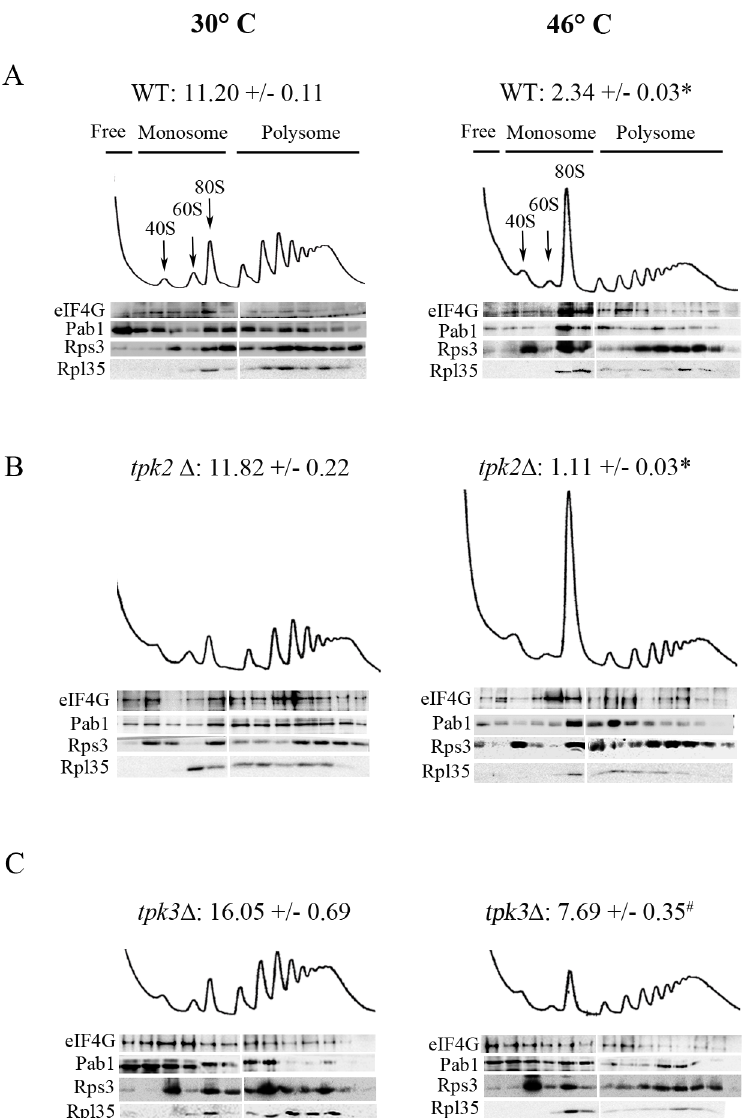
Fig 5. Tpk2 and Tpk3 show an opposite role in translational arrestin response to severeheat stress. Polysomalprofile analysisand immunoblots of 15–50%sucrose gradientfractions from WT (A), tpk2 Δ and tpk3 Δ cells grown to exponential phase in YPD (30˚C) and subjectedto severe heat stress (46˚C for 10 minutes). Free, monosome and polysomeregionsare indicatedover the polysomeprofile. The numbers representthe polysome/monosomearea ratio (mean +/- SEM, n = 3). * p < 0.05 WT and tpk2 Δ 30˚C versus 46˚C; # p < 0.05 tpk3 Δ versus WT and tpk2 Δ 46˚C (ANOVA Bonferroni post-test). Quantificationof translation factors in monosome fraction (M) and polysome fraction (P) are shownin S1E